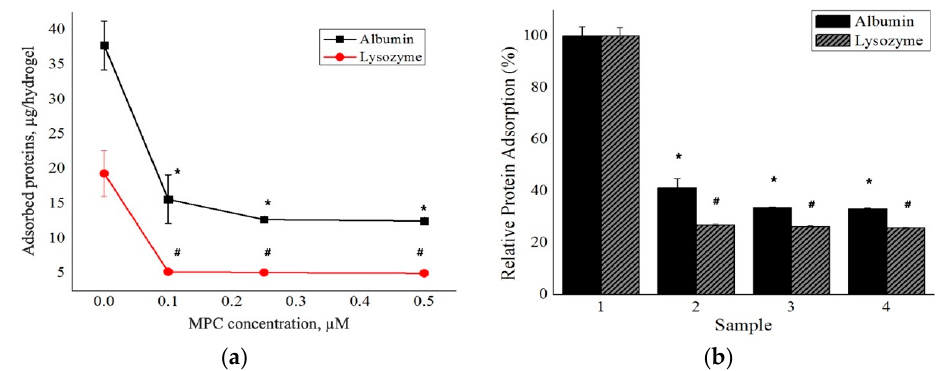
Figure 3. Protein adsorption profiles of the poly(2-methacryloyloxyethyl phosphorylcholine)-surface- functionalized hydrogels in terms of ( a ) mass of adsorbed proteins per hydrogel and ( b ) relative protein adsorption (%) (*,# = p < 0.05 compared to the control). Legend: 1 = p(HEMA)-H; 2 = p(HEMA) / p(MPC)0.1; 3 = p(HEMA) / p(MPC)0.25; 4 = p(HEMA) /